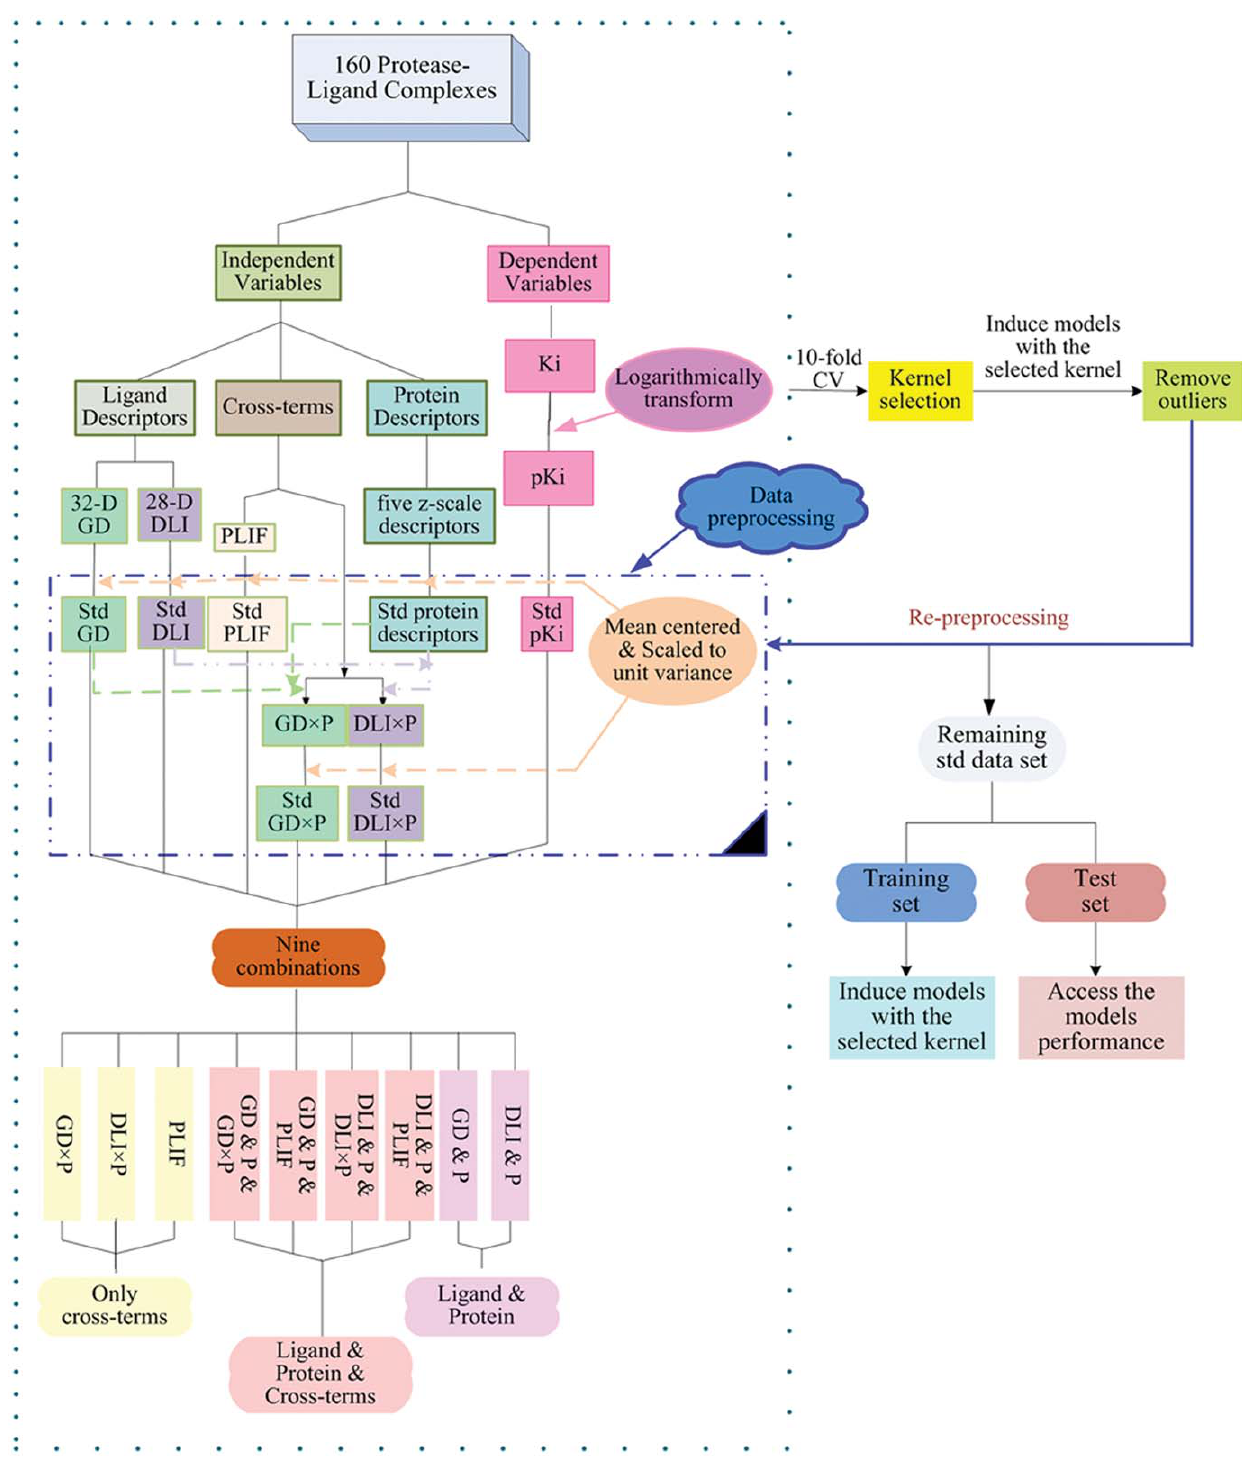
Figure 1. Graphical illustrations of the goodness-of-fit and predictive ability of the obtained models with the selected kernel. Goodness-of-fit is shown as red solid circles, and predictive ability is shown as blue solid circles. The predicted versus measured activity values using different combinations of descriptor blocks, i.e. GD 6 P (a), DLI 6 P (b), PLIF (c), GD & P & GD 6 P (d), GD & P & PLIF (e), GD & P (f), DLI & P & DLI 6 P (g), DLI & P & PLIF (h), DLI & P (i) are shown in the figure. etc . As a result, 160 protease-ligand complexes with inhibition constants ( K i ) were retrieved from PDB database, including 92 chemical compounds and 47 HIV-1 protease variants. Inhibition